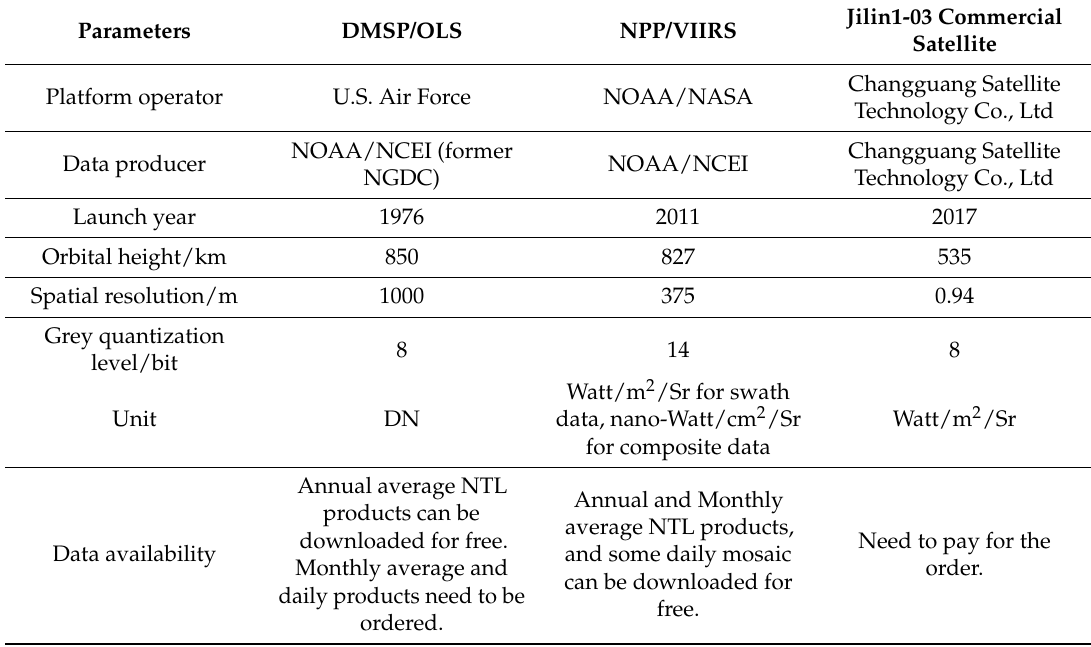
Table 1. Basic information of DMSP/OLS, NPP/VIIRS, and the Jilin1-03 NTL imageries.